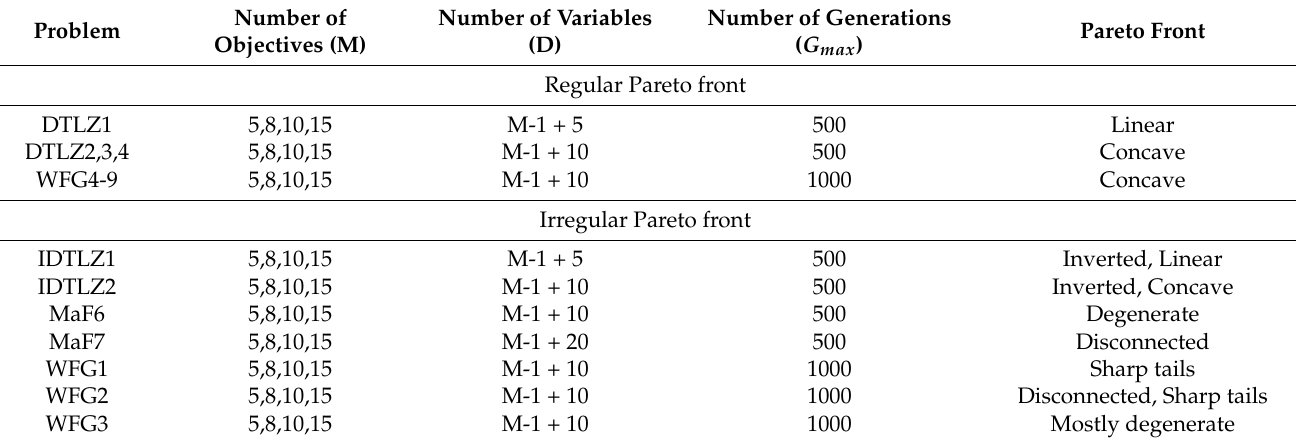
Table 1. Settings of the number of objectives, variables and maximum generation for each test